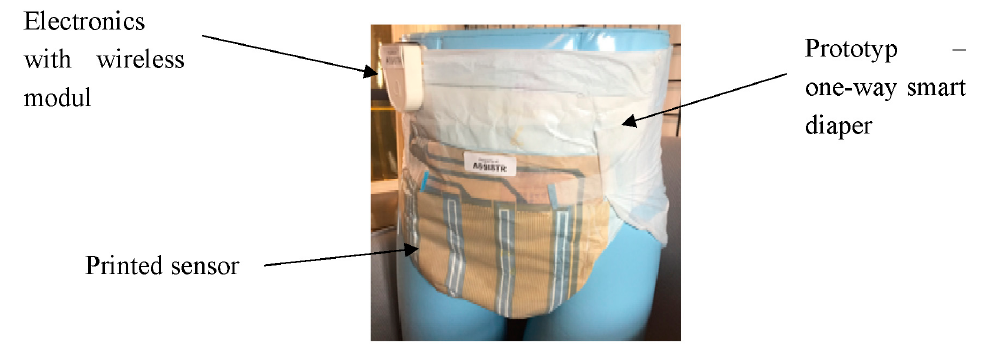
Figure 4. The smart diaper prototype with electronics and wireless module.